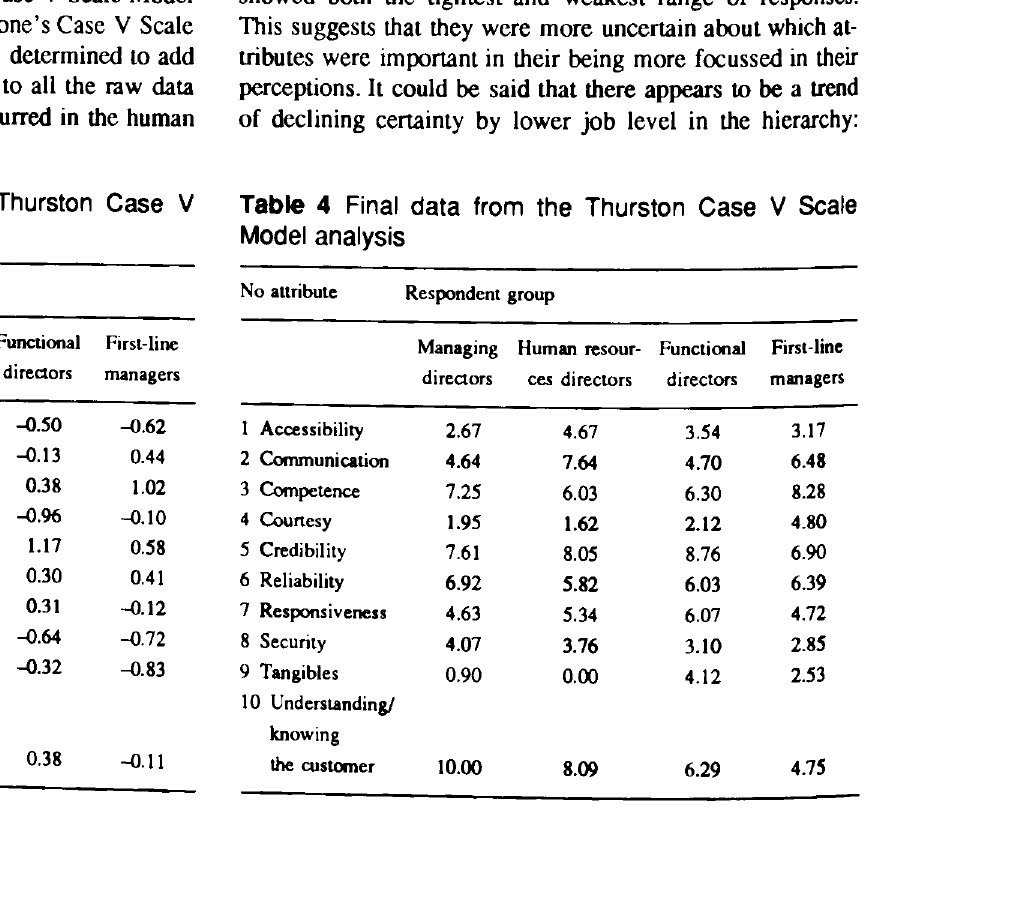
Table 3 Raw data from the initial Thurston Case V Table 4 Final data from the Thurston Case V